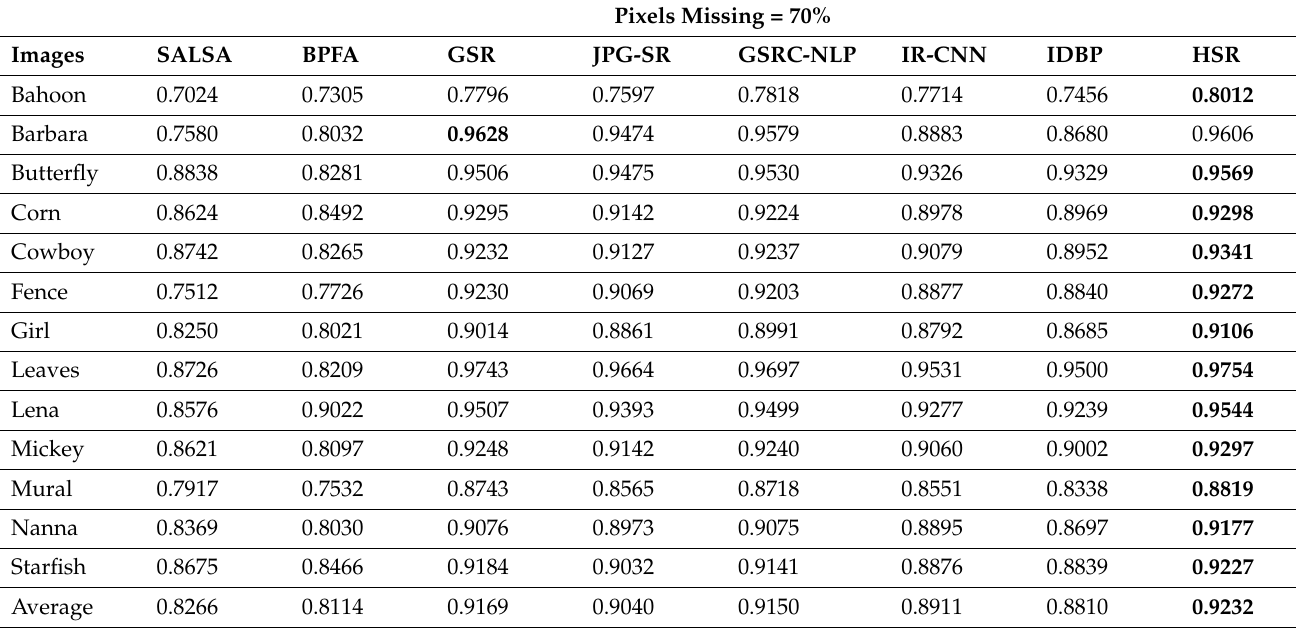
Table 6. SSIM values of our proposed HSR model and other comparison models after image restora- tion with pixels missing rate